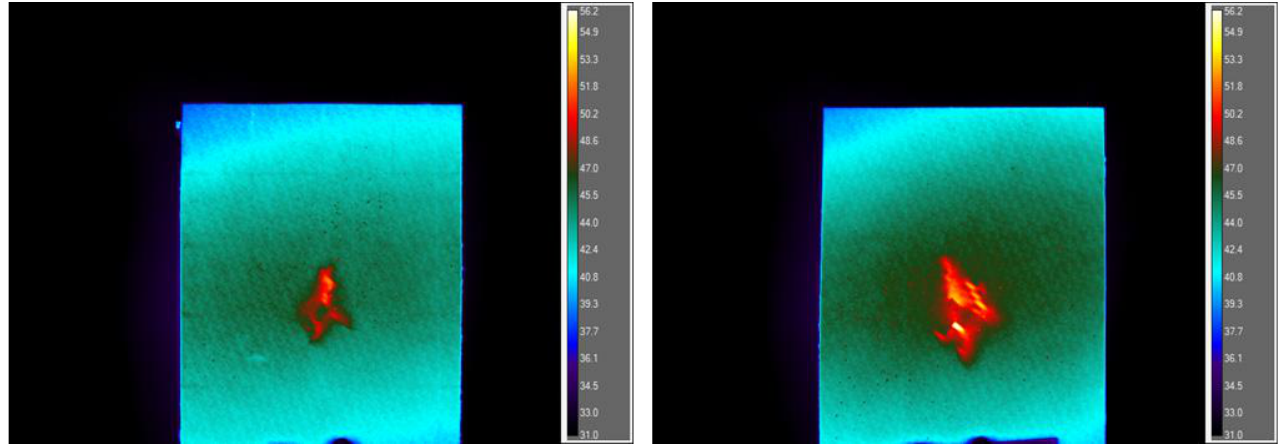
Figure 23. IR Thermography of damage on repaired 3R laminates at 9 J ( left ) and 15 J ( right ).